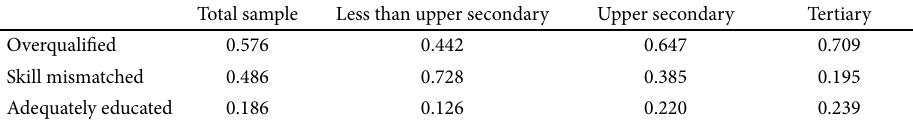
Table 2. The incidence of mismatch by educational levels. Pooled sample Total sample Less than upper secondary Upper secondary Tertiary Overqualified 0.576 0.442 0.647 0.709 Skill mismatched 0.486 0.728 0.385 0.195 Adequately educated 0.186 0.126 0.220